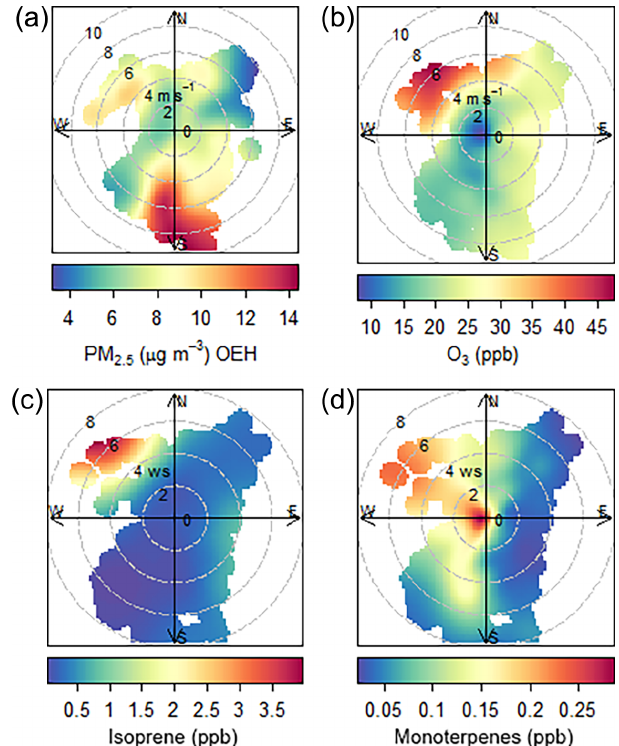
Figure 6. Bivariate polar plots showing how (a) the concentration of PM 2 . 5 (µgm − 3 ) at the OEH station and the mole fractions (ppb) of (b) O 3 , (c) isoprene and (d) monoterpenes at the main MUMBA site varied as a function of wind speed (ms − 1 ) and wind direction during the